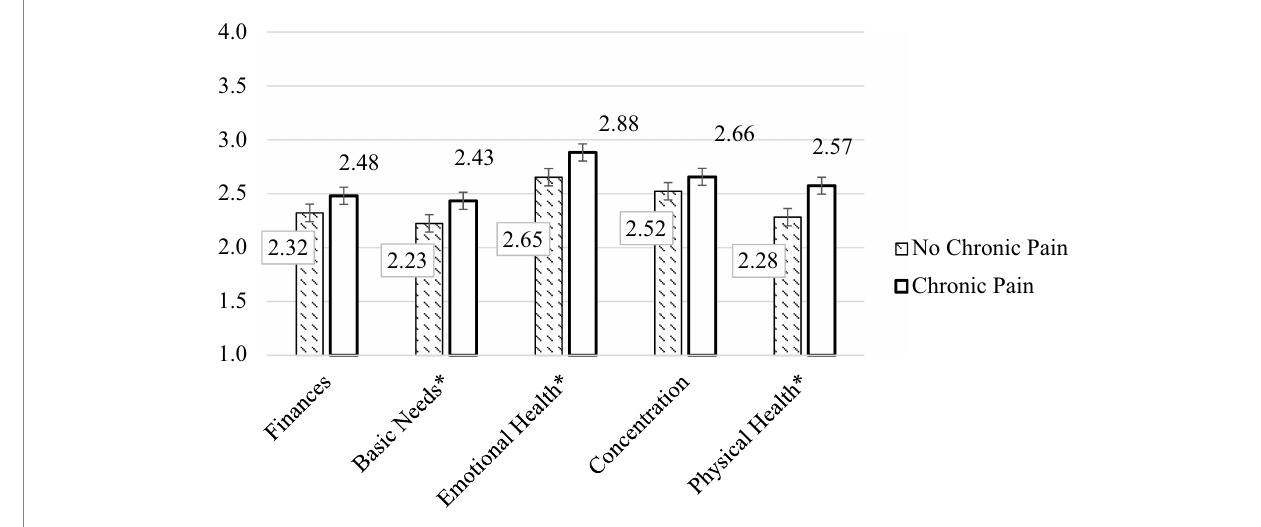
FIGURE 1 Decline in major areas of quality of life during COVID-19. *indicates significant difference between groups.